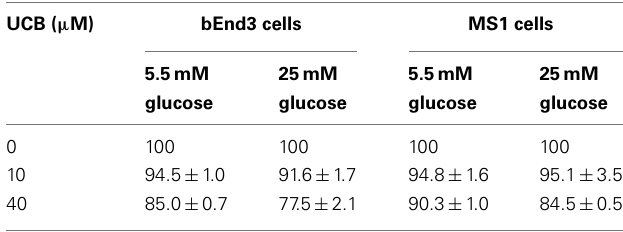
Table 1 |Viability of microvascular endothelial cells exposed to UCB in normal or high glucose-containing culture